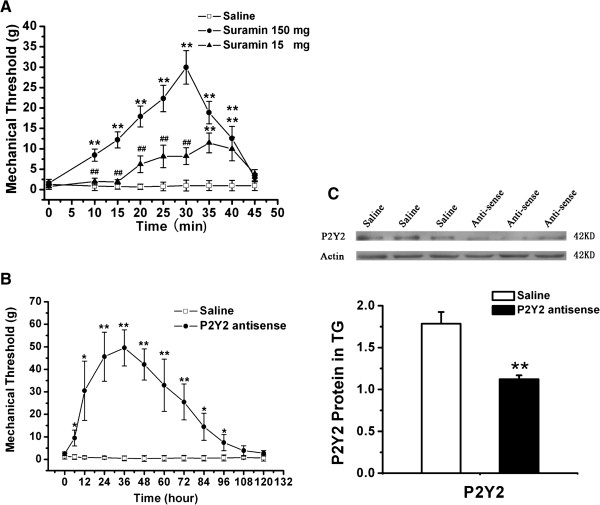
The role of P2Y2 receptors in mechanical hyperalgesia in ION-CCI rats. (A) The peripheral target injection to TG of suramin (0.3-3 μg/μl) reduced mechanical allodynia in the whisker pad. n = 6-8, **, p < 0.01 compared with injection of saline, ##, p < 0.01 compared with injection of high-dose suramin. Suramin led to a time- and dose-dependent increase in PWT, this anti-allodynia effect started 10 min after the suramin injection and remained for at least 45 min. (B) The peripheral target injection to TG of P2Y2 antisense oligodeoxynucleotides significantly alleviated mechanical allodynia of the whisker pad. n = 5, *, p < 0.05, **, p < 0.01 compared with injection of saline. The effect started at 6 h and persisted for at least 120 h. (C) Western blots showed successful suppression of P2Y2 receptor expression in TG by P2Y2 receptor antisense oligodeoxynucleotides treatment n = 4 for each group, **, p < 0.01.